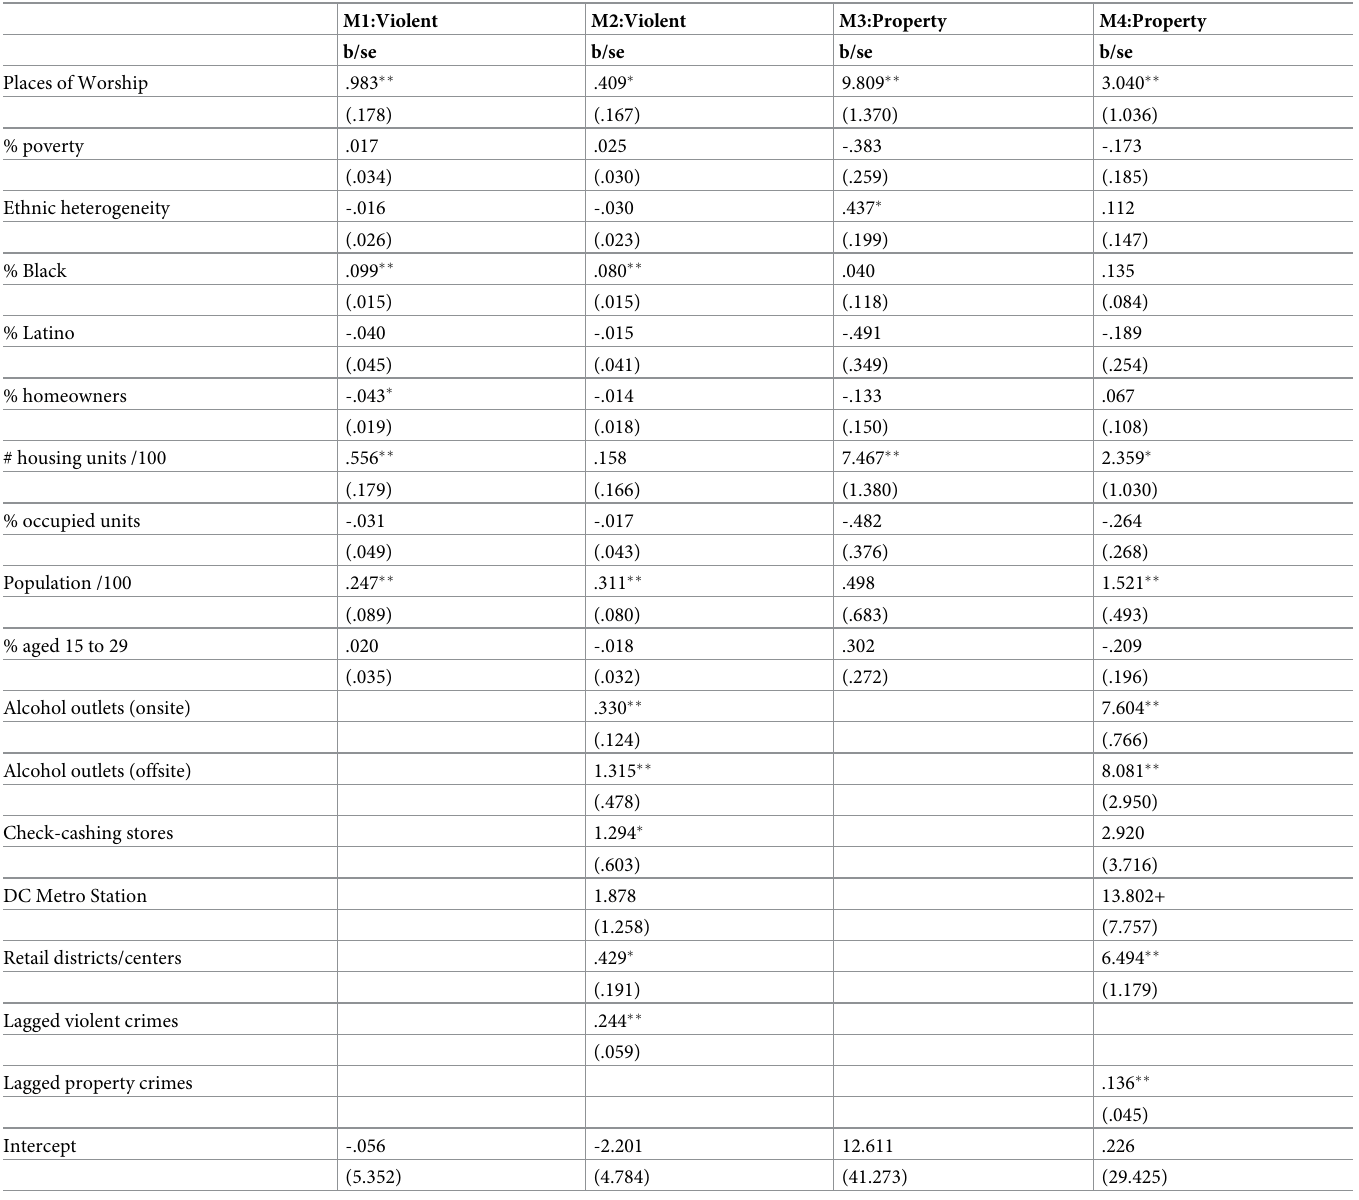
Table 4. Ordinary least squares regression: POW effects on neighborhood